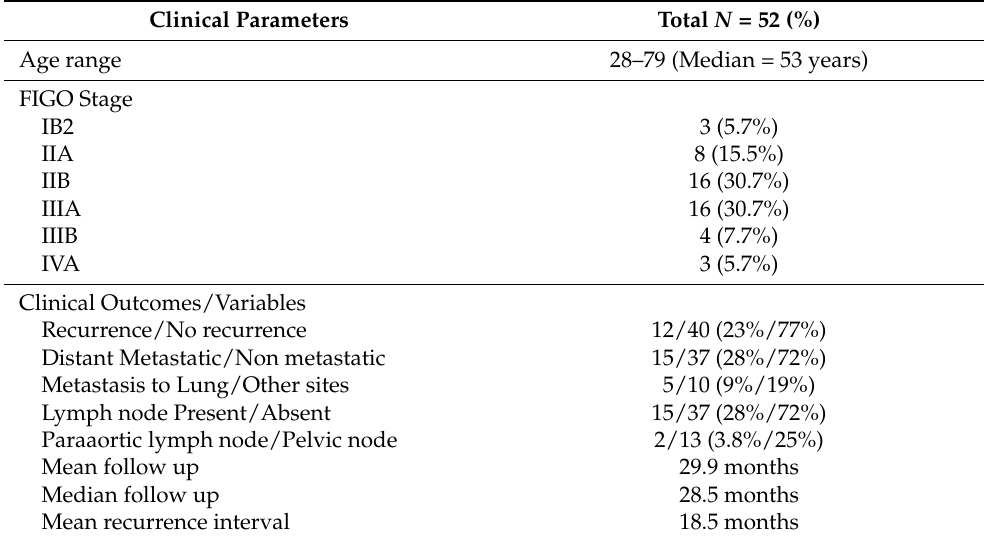
Table 1. Clinical characteristics of patients included in study.